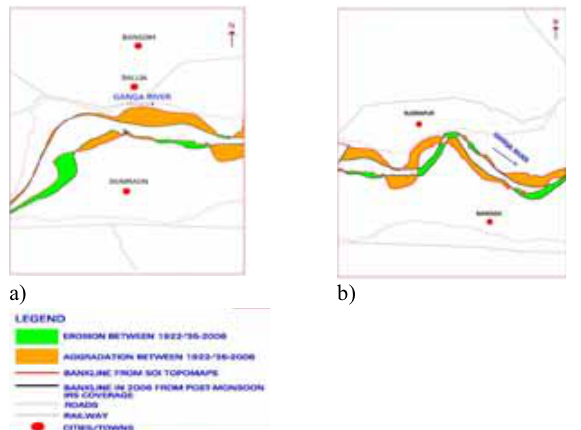
Fig 4 (d): Fluvial features as demarcated from 2004 pre-